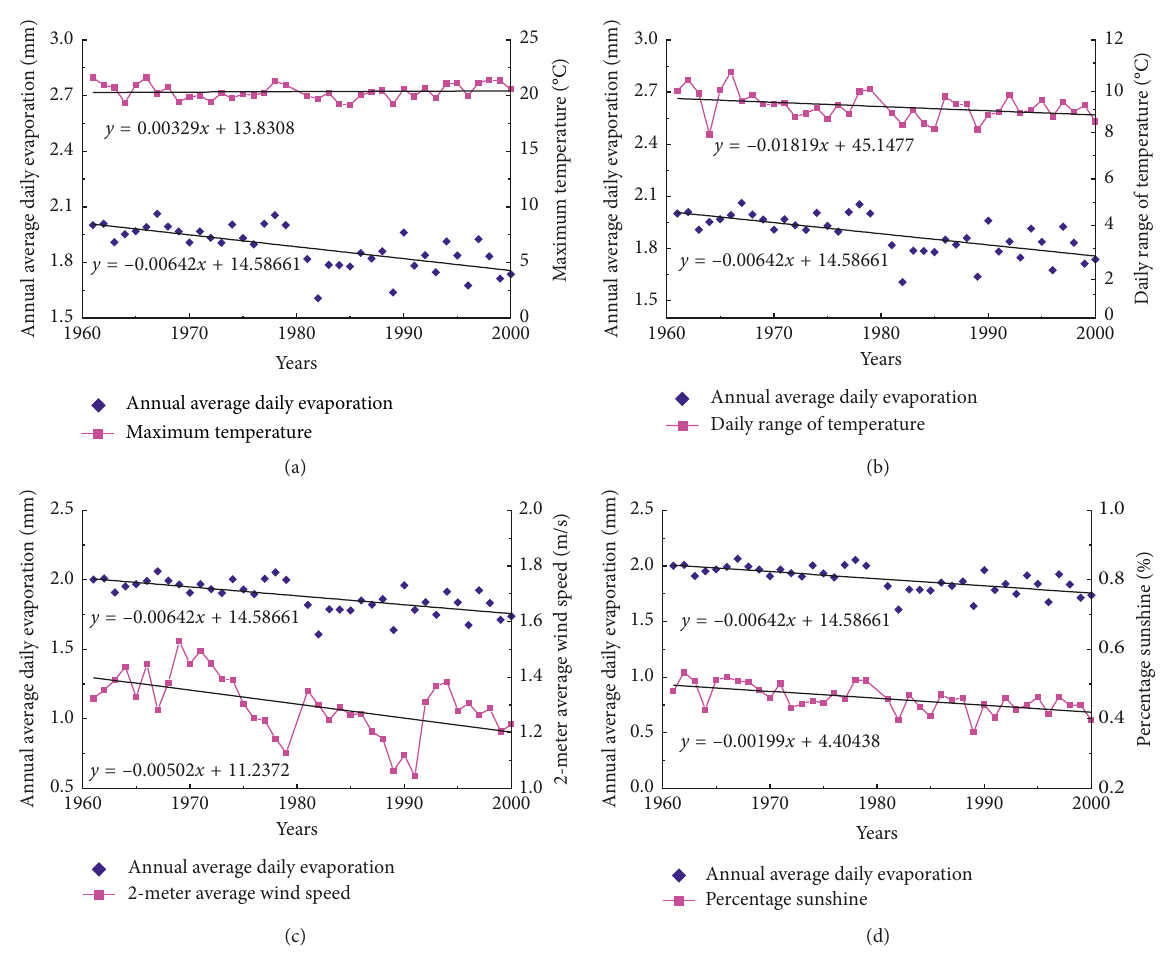
Figure 6: Variation trend graphs of maximum temperature, daily range of temperature, 2-meter average wind speed, and percentage sunshine with actual